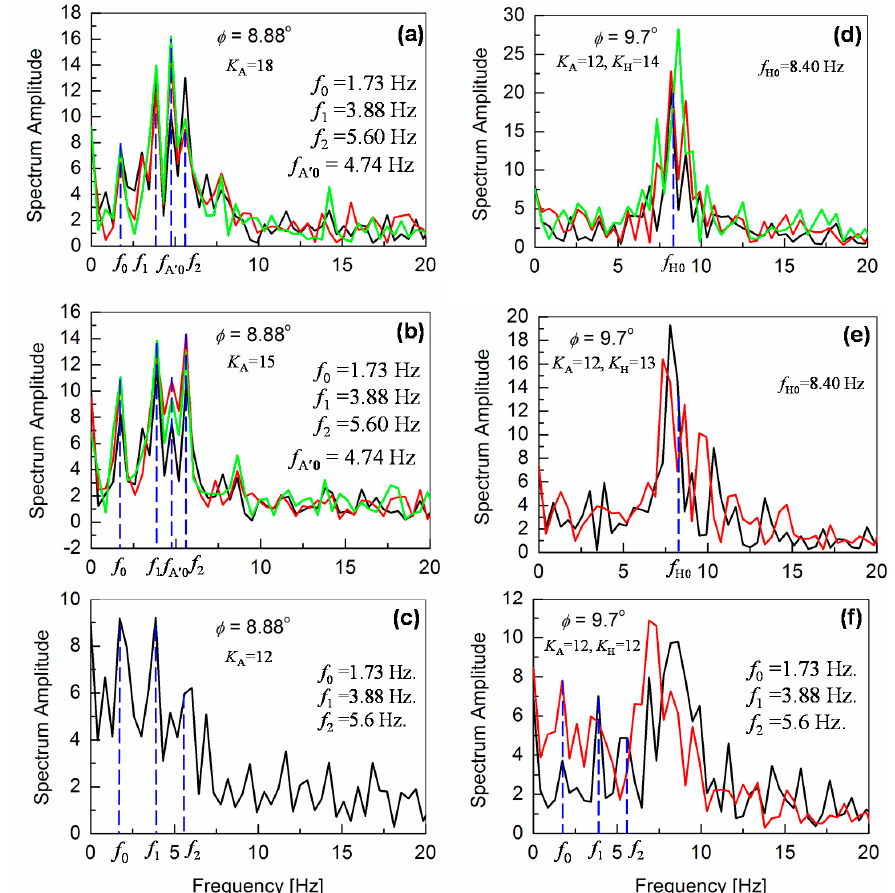
Figure 12. Fourier analysis of the angular-pitch velocity of the robot walking on an inclined surface for φ = 8.88° with varying K A (18 in ( a ), 15 in ( b ), and 12 in ( c )) and for φ = 9.7° with varying K H (14 in ( d ), 13 in ( e ), and 12 in ( f )). By reducing K A and K H values, the robot posture becomes unstable due to slipping, as shown in ( b ) and ( c ).